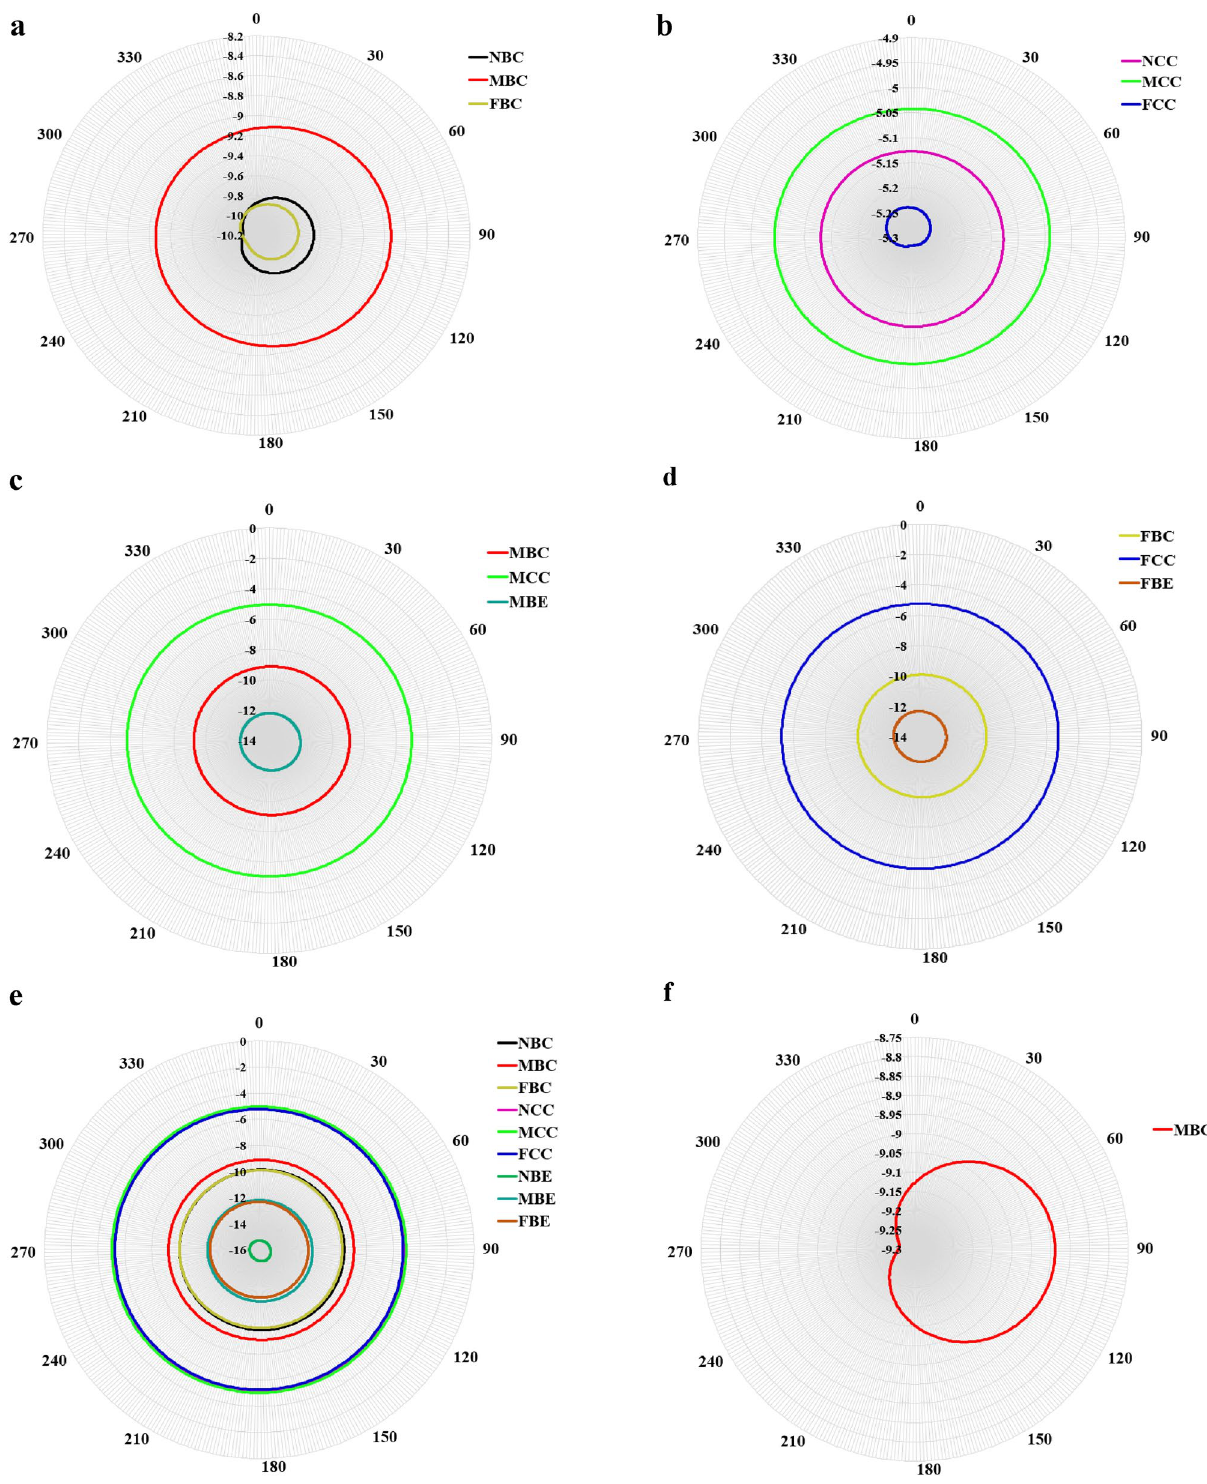
Figure 13. Far-field directivity of sound pressure comparison for different location categories of the sound source at f = 146 Hz ( a ) LC1, ( b ) LC2, ( c ) LC5, ( d ) LC6, ( e ) all locations, ( f )